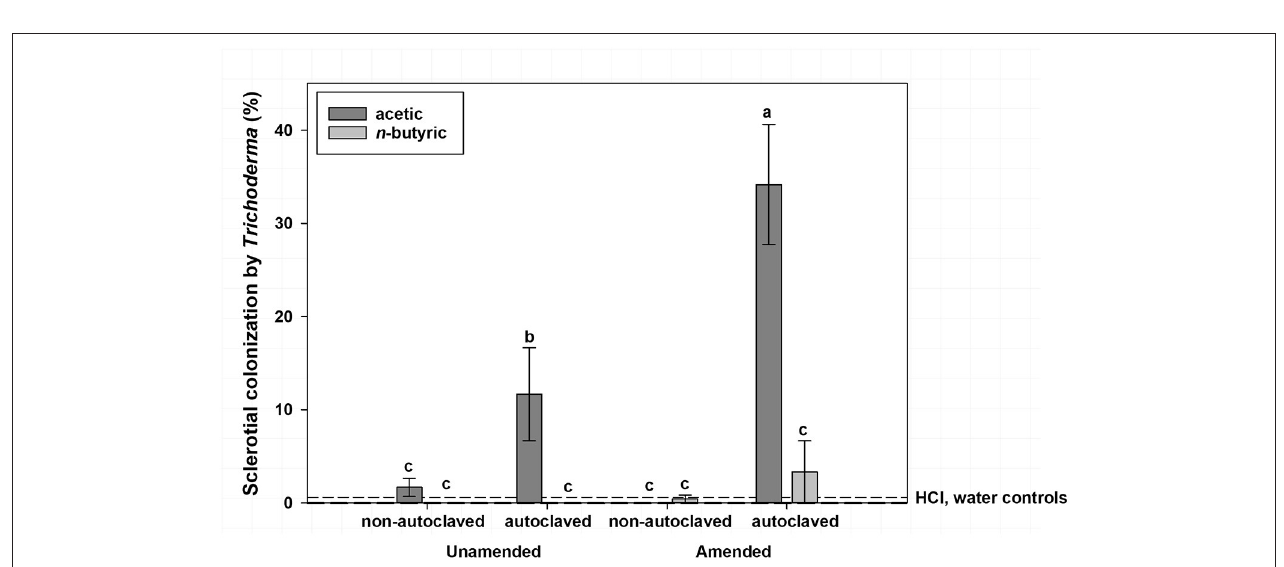
FIGURE 4 | Mean percentage colonization of A. rolfsii sclerotia by Trichoderma spp. in experiment 1 as affected by volatile fatty acid (VFA), soil autoclaving, and soil amendment. Bars indicated by the same letter are not significantly different according to an F-protected LSD at P ≤ 0.05. Error bars represent standard error of the